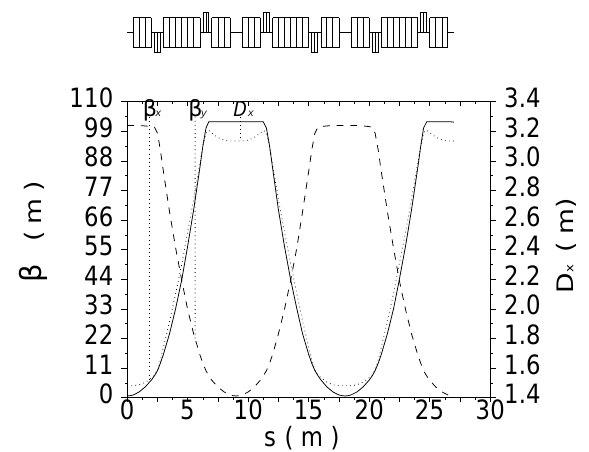
FIG. 45. Example (a): The chromatic correction module.